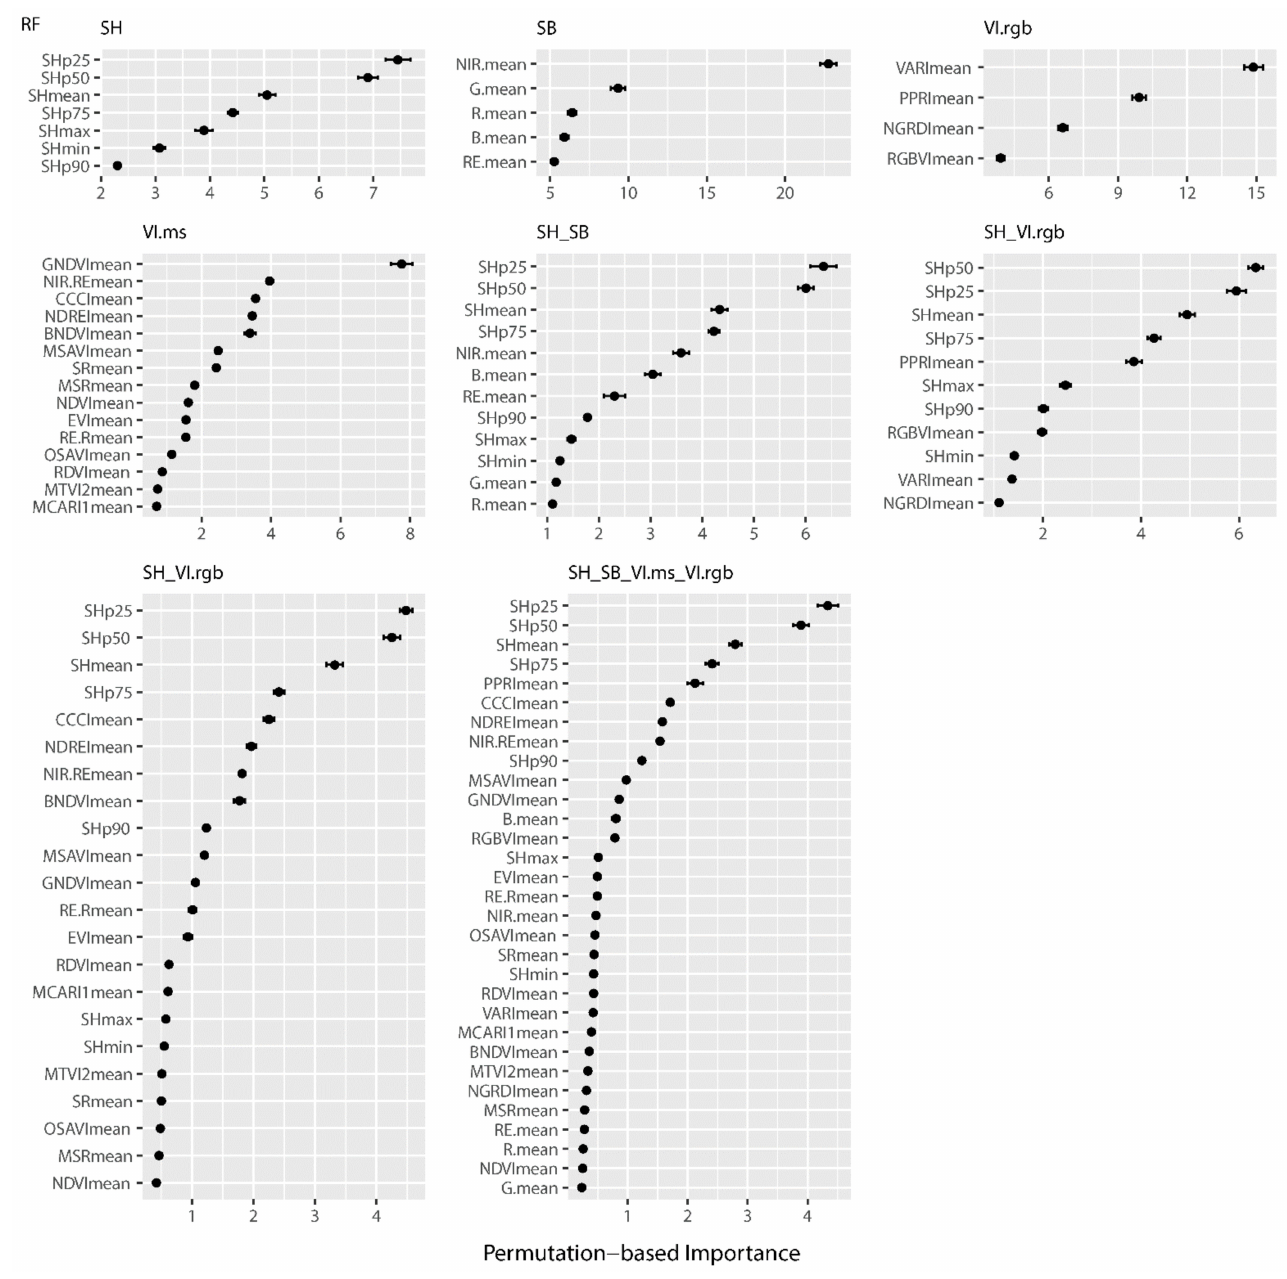
Figure A8. VIP of Nup estimation with